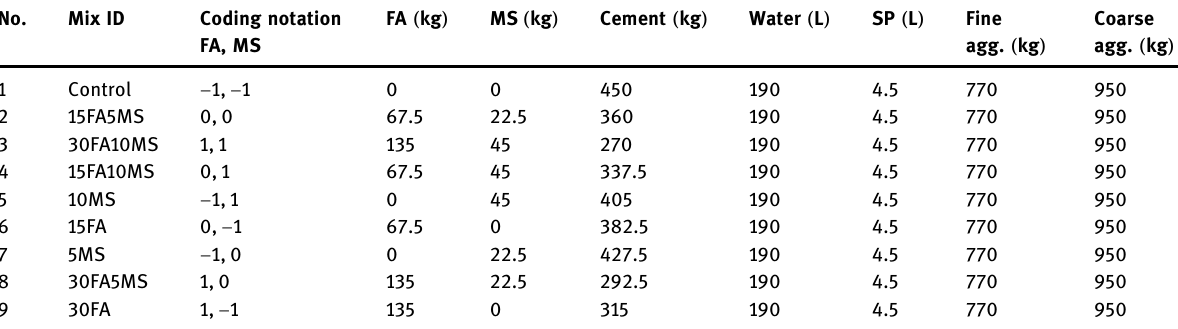
Table 3: Mix proportion for a cubic meter mixture